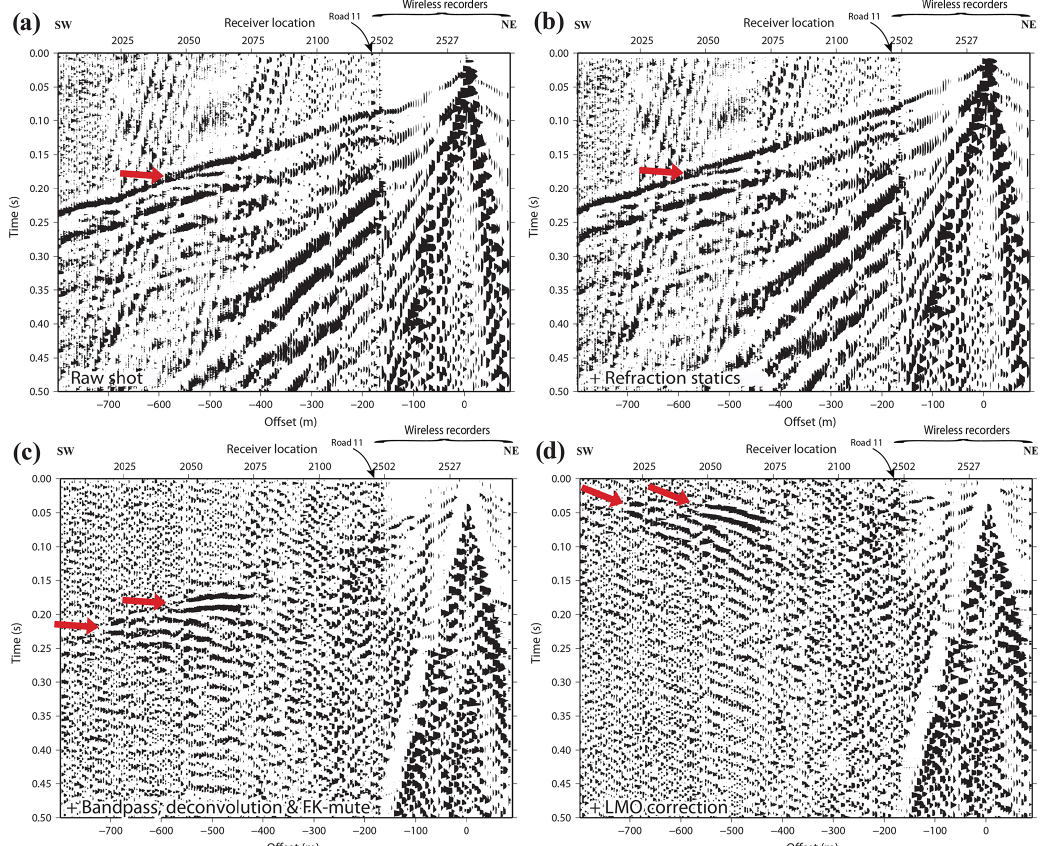
Figure 5. (a) An example shot gather from profile 2 (after vertical stacking of the three repeated shot records) showing the quality of the first breaks and how merged cabled and wireless data were used for both refraction data analysis and reflection data processing. Note the high level of noise from Road 11 remained as surface-wave energy (steep or low velocity) but was also a noticeable reflection (dipping towards the northeast) in the raw data that became much stronger after (b) refraction static corrections, (c) prestack data enhancement (two sets of reflections) and (d) linear move-out (LMO) corrections (for display purpose). Two sets of reflections (marked by red arrows in panel d ) are notable between receivers 2020–2040. The application of a median filter and dip filter (FK filter linked with linear move-out correction) helped to enhance these reflections in prestack gathers